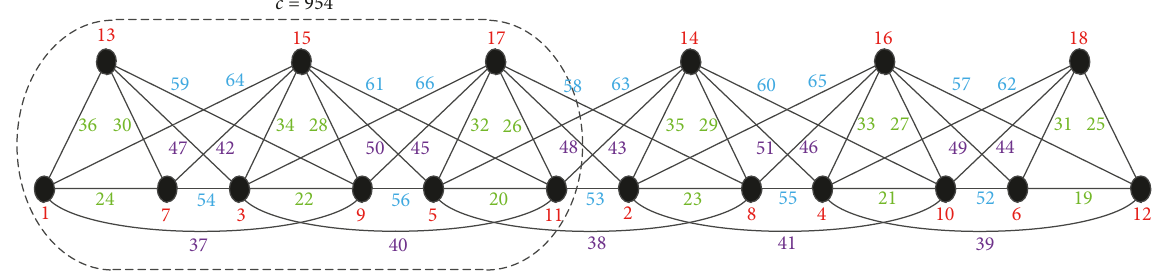
Figure 2: 𝐷 3 (𝐶 3 ) -supermagic labeling of 𝐷 6 (𝐶 3 ) with magic constant 𝑐 =